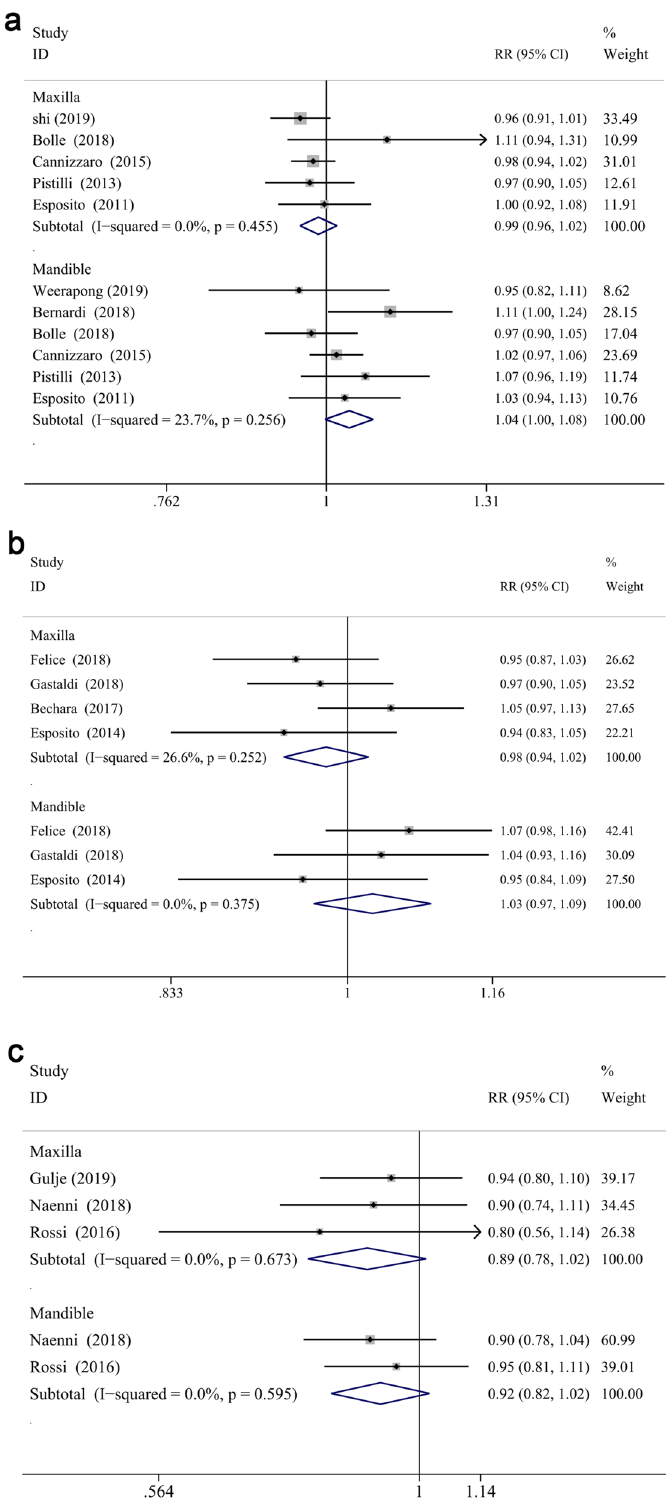
Figure 3. Subgroup analyses of maxilla/mandible on survival rate at 1-year ( a ), 3-years ( b ), 5-years ( c ) follow-up. Mantel–Haenszel (MH)-weighted RR < 1 indicated a lower survival rate of extra-short implants than the longer